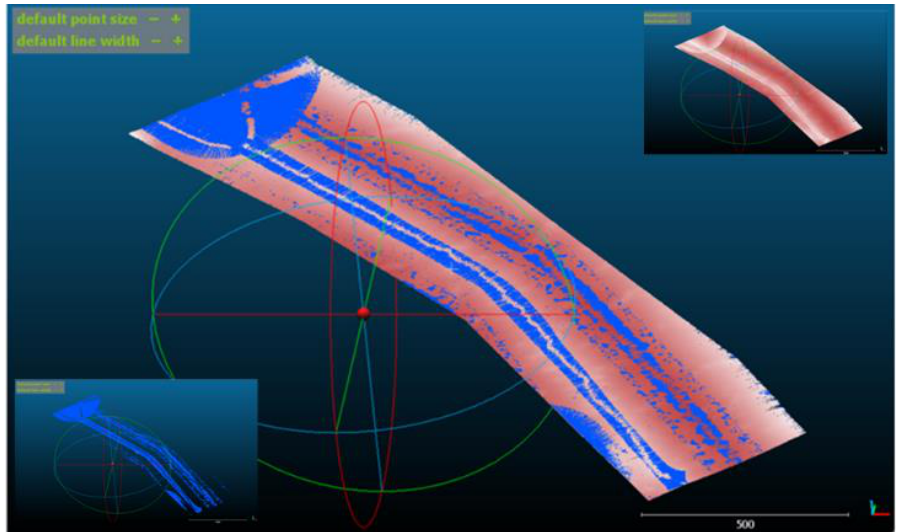
Figure 15. An example of filtering using the CSF method.